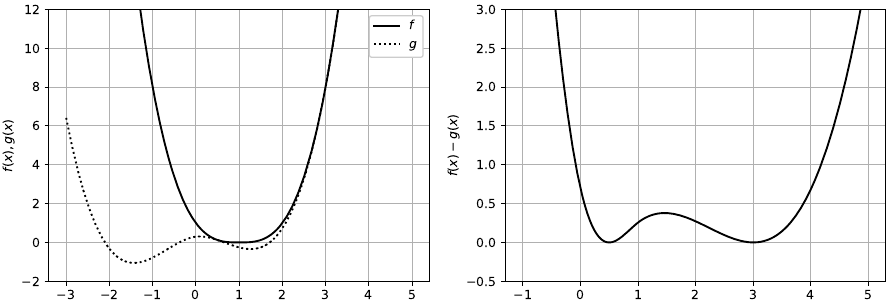
Figure 4. Plots of the functions f ( x ) = | x − 1 | 3 and g ( x ) = a + bx + cx 2 + d | x | 3 from Lemma 1 ( left ), and the plot of the difference f − g ( right ) for u = − 1, v = 2 ( d < 0). The unique minimum point of g lies between the tangency points u and v . The maximum points lie to the left from u and to the right from v .